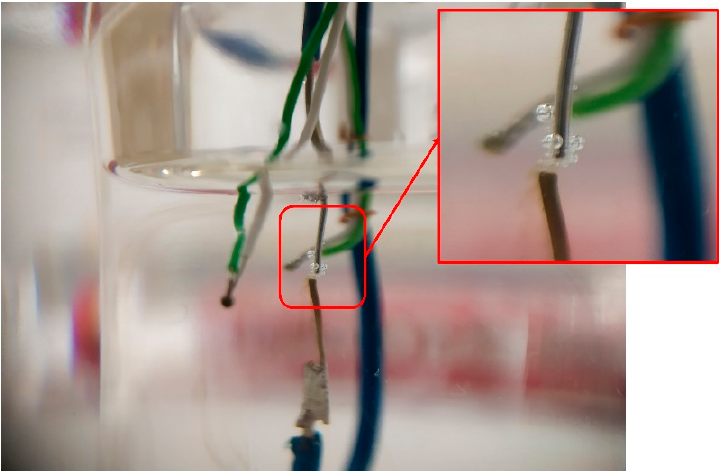
Figure 10. Bubble formation at 50 V during ca. 20 s.